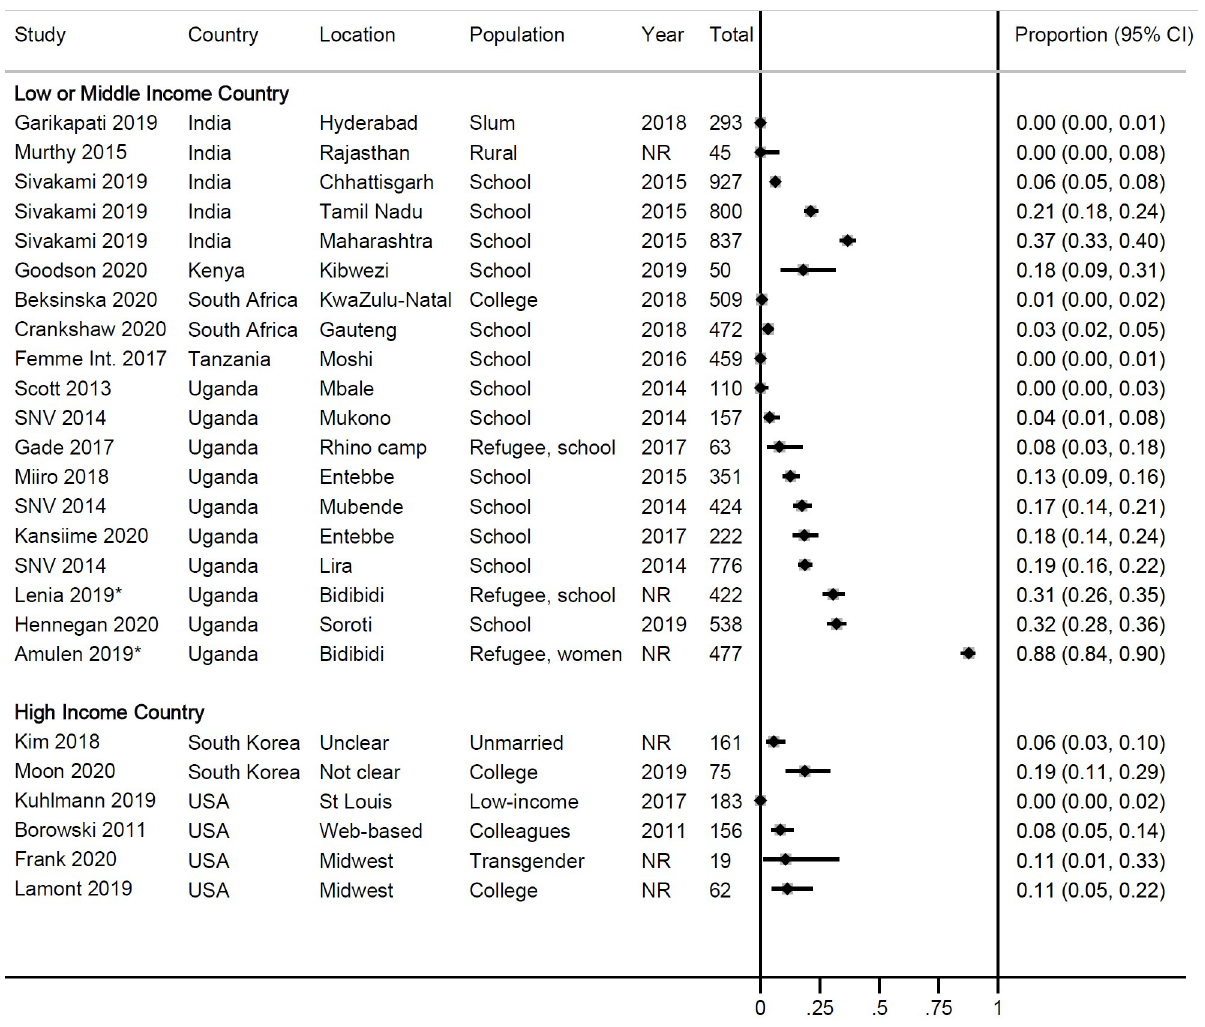
Fig 2. Use of reusable pads in surveys or at enrolment in a cohort, 2011–2019. � According to the website, Bidibidi camp received reusable pads in August 2017 [57]. However, Lenia 2019 described that both reusable and disposable pads were distributed